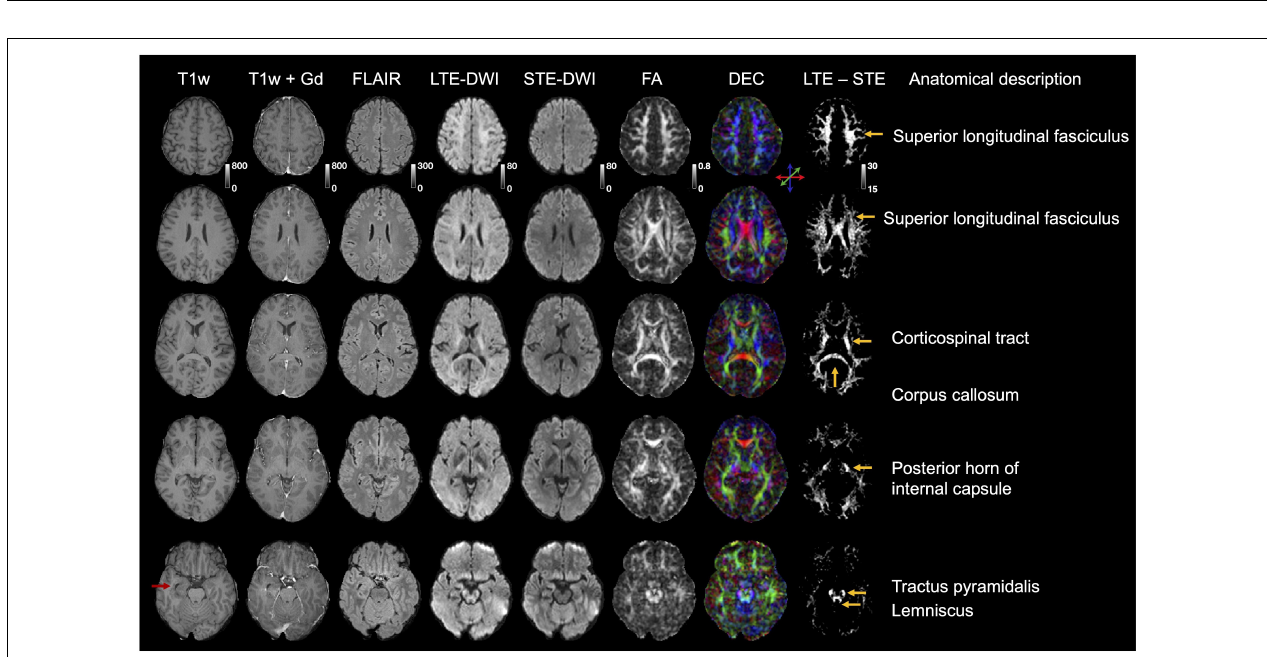
FIGURE 6 | Illustration of the difference between LTE-DWI and STE-DWI in a patient without MRI brain abnormalities, except for a vascular malformation (telangiectasia) in right temporal lobe outside of evaluated regions (red arrow). This patient was previously referred to as C1 and is shown in several slices. Rightmost column shows difference maps between LTE-DWI and STE-DWI at b -value of 2,000 s/mm 2 windowed such that only the highest differences are visible. The difference maps shows that the major white matter tracts are the most suppressed by STE-DWI (tract names shown in the righthand side of the figure). The LTE- and STE-DWI were shown with the same colormap (“windowing”). DEC = direction encoded color map.